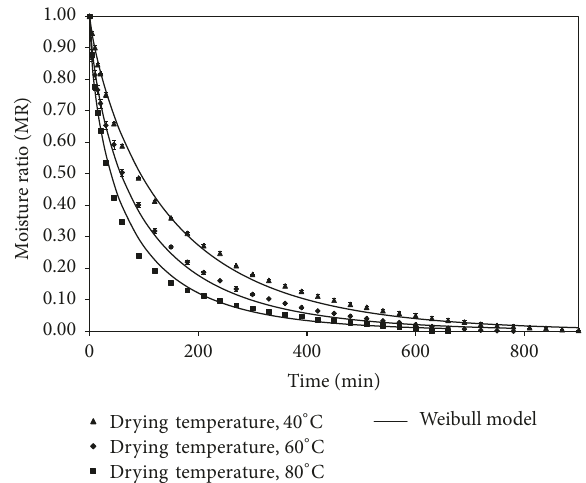
Figure2:ExperimentaldryingcurvesmodeledbytheWeibullmod-